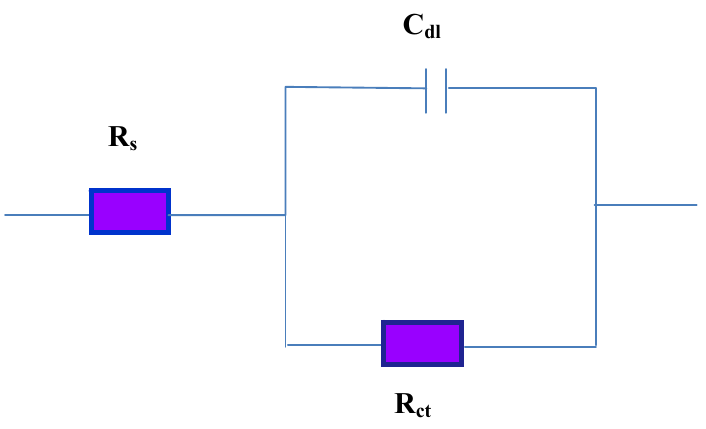
Figure 7. Equivalent electrical circuit used in fitting EIS data.